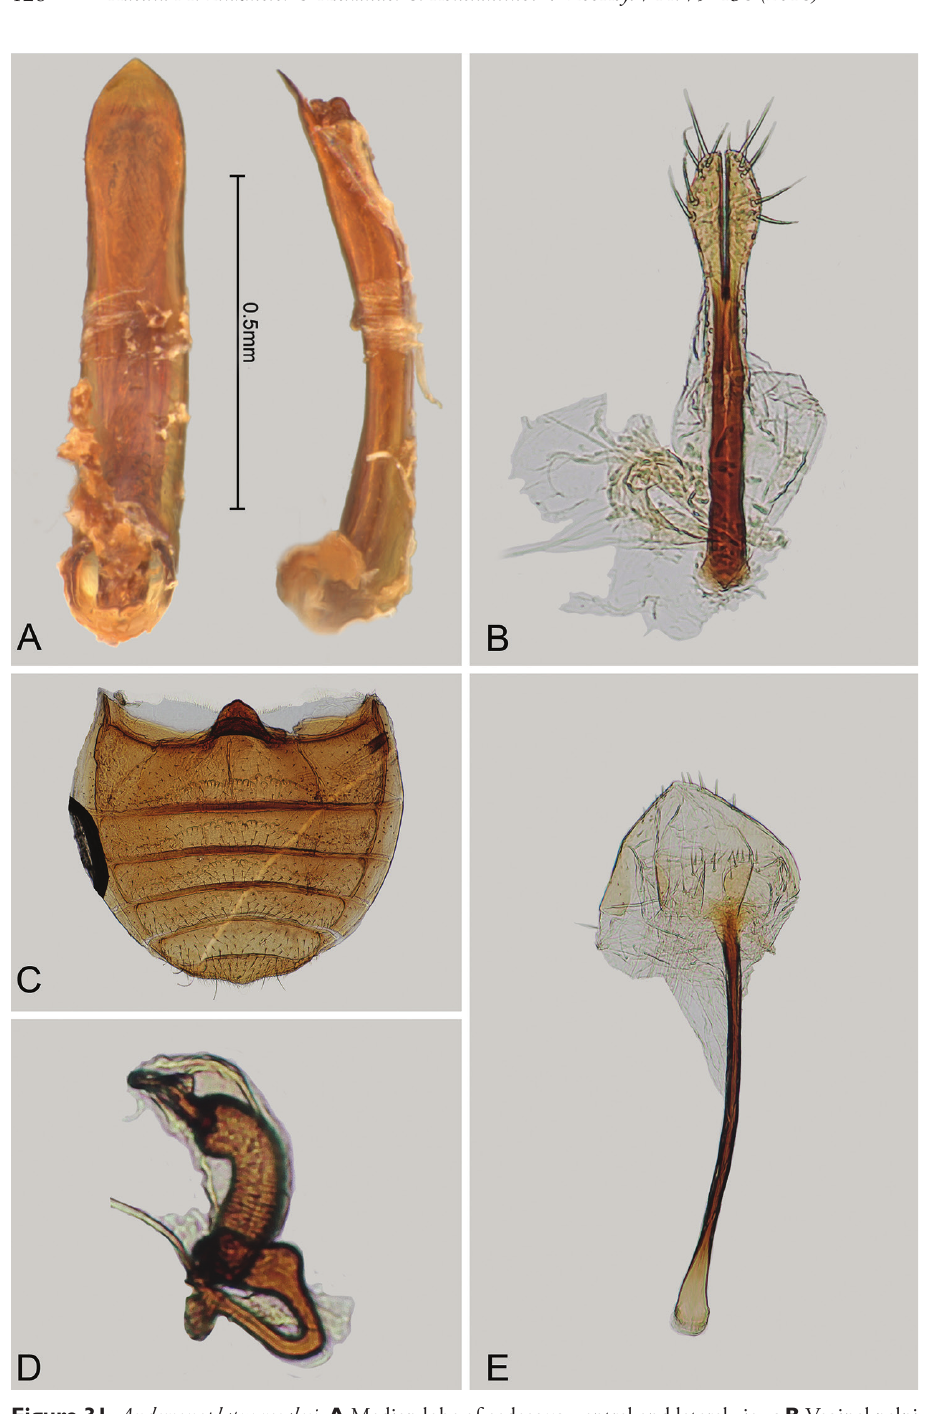
Figure 31. Andersonoplatus rosalesi . A Median lobe of aedeagus, ventral and lateral views B Vaginal palpi C Female abdomen, ventral view D Spermatheca E